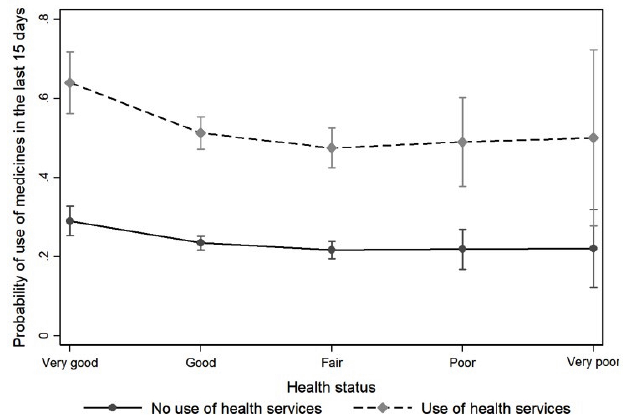
FIGURE 1 - Predictive probability of use of medicines according to the health status and use of health services in the 15 days prior to data